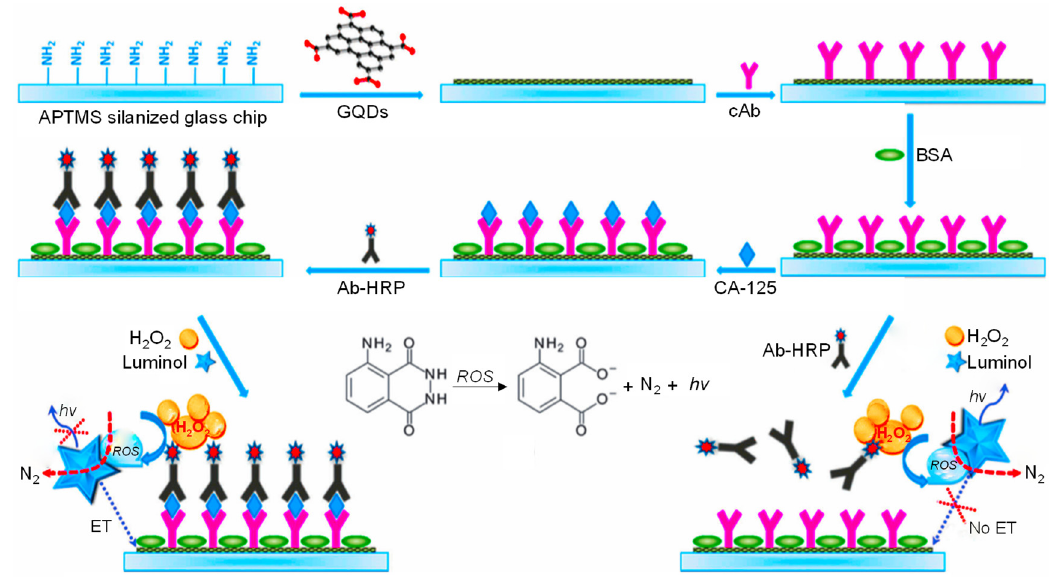
Figure 9. Schematic illustration of CL-based GQD sensor for CA-125 determination [181]. Reproduced by permission of The Royal Society of Chemistry.